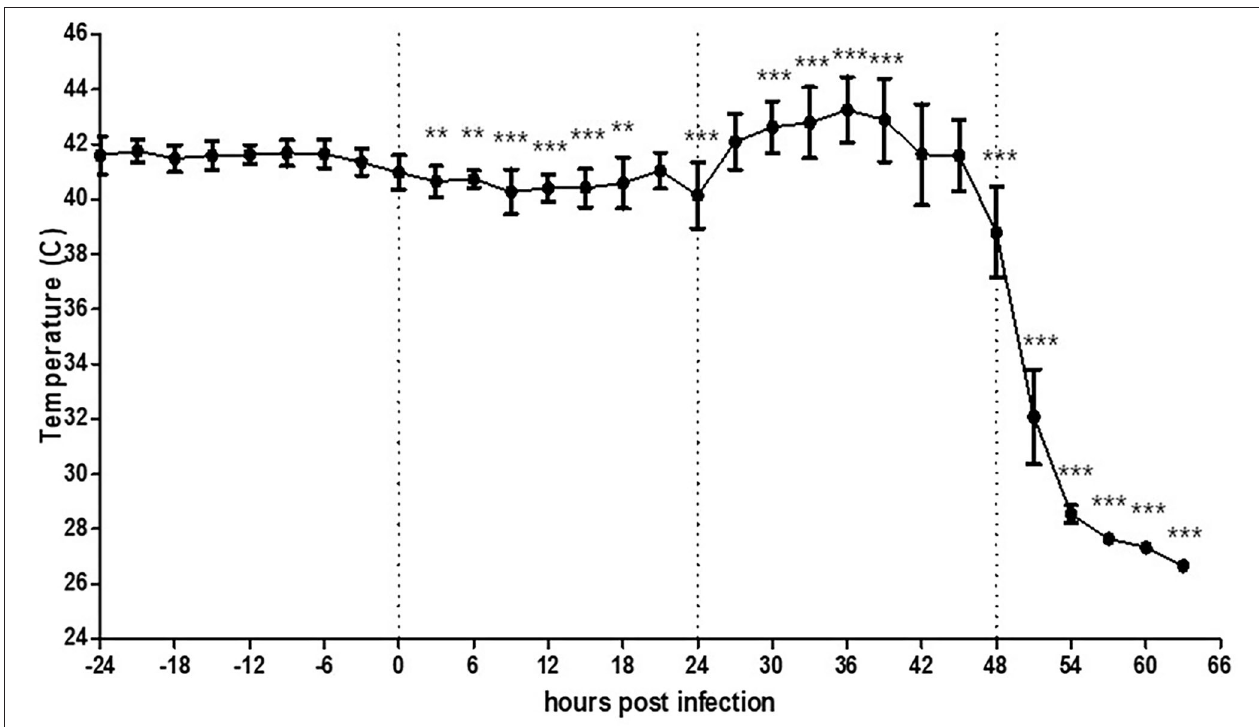
FIGURE 2 | Average temperature per 3h interval before and after HPAI virus challenge in chickens ( n = 5). Chickens were further monitored several more hours after death without removal. The error bars represent standard deviations of 36 5-min time points. Statistical significance was determined using ANOVA followed by Bonferroni post-hoc test. *** P < 0.001; ** P <